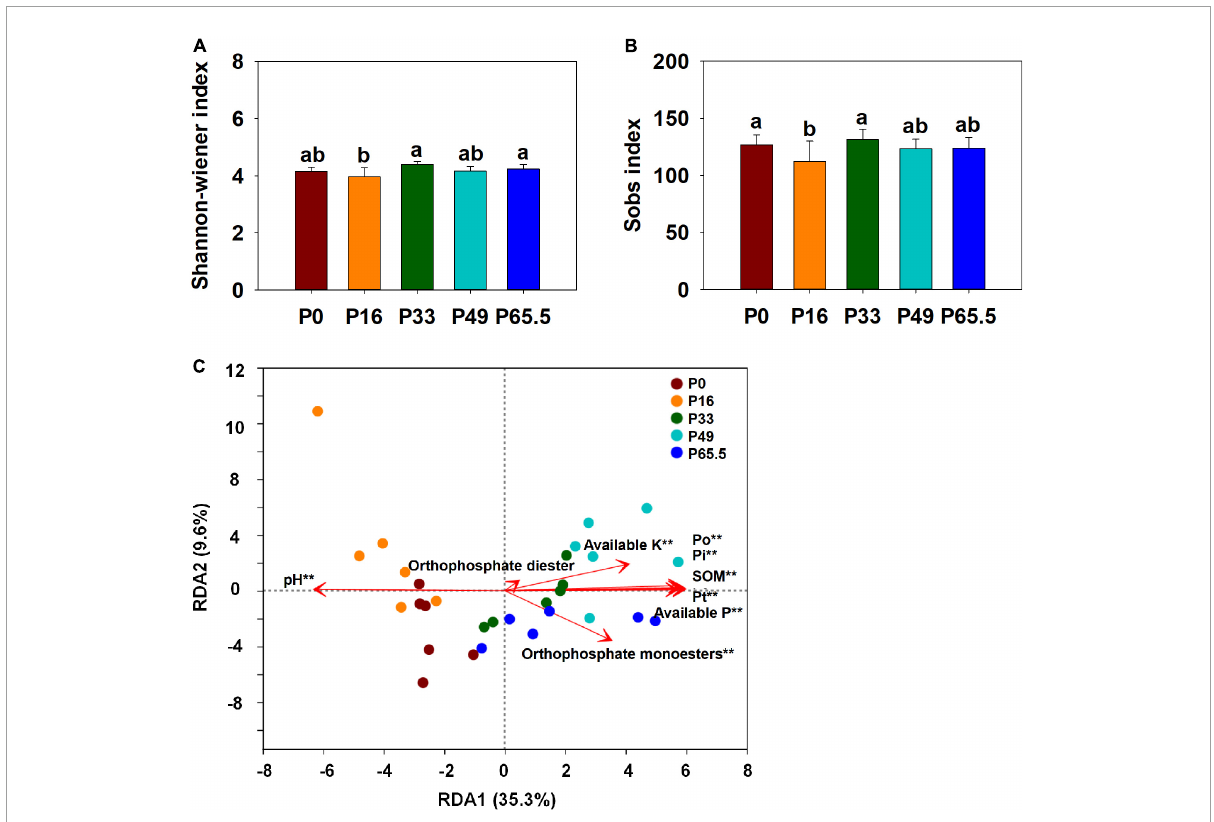
FIGURE3 Alpha diversity (A,B) and redundancy analysis (RDA) (C) of phoD -harboring bacteria under gradient P fertilization. In (A,B) , small letters indicate significant differences ( P < 0.05 after the Duncan test) between P levels. In (C) , RDA was used to explore the relationship between the entire phoD -harboring bacterial community and selected soil properties. **Correlation is significant at the 0.01 level. P0, P16, P33, P49, and P65.5 represent 0, 16, 33, 49, and 65.5 kg P ha − 1 , respectively.